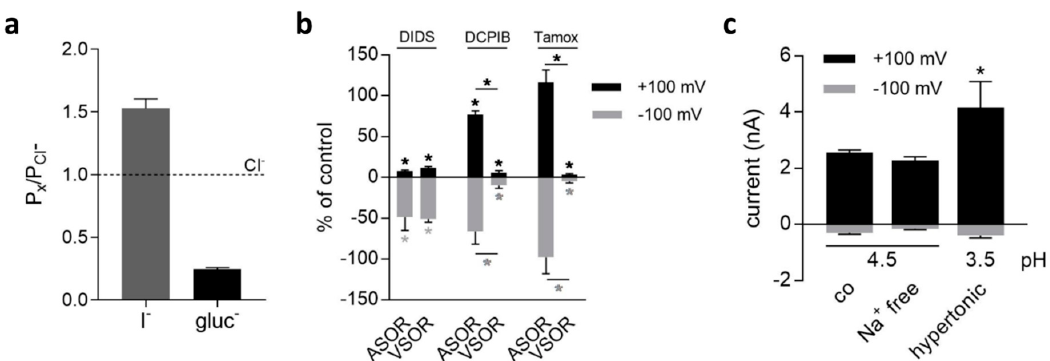
Figure 2. ( a ) ASOR current anion permeability in BV-2 cells (gluc − , gluconate − ); ( b ) Pharmacology of ASOR and VSOR currents. Currents at +100 (black bars) and − 100 mV (grey bars) in presence of DIDS (100 µM), DCPIB (10 µM), or tamoxifen (Tamox; 10 µM) in % of current amplitudes measured in the absence of inhibitors. Black and grey asterisks indicate significant differences at +100 and − 100 mV, respectively (* p < 0.05); ( c ) ASOR current activation under Na + free ( n = 3) and hypertonic conditions (350 mOsm/kg; n = 3) as compared to control (co) currents at pH 4.5 (300 mOsm/kg; n = 26). Mean values ± SEM (* p < 0.05).